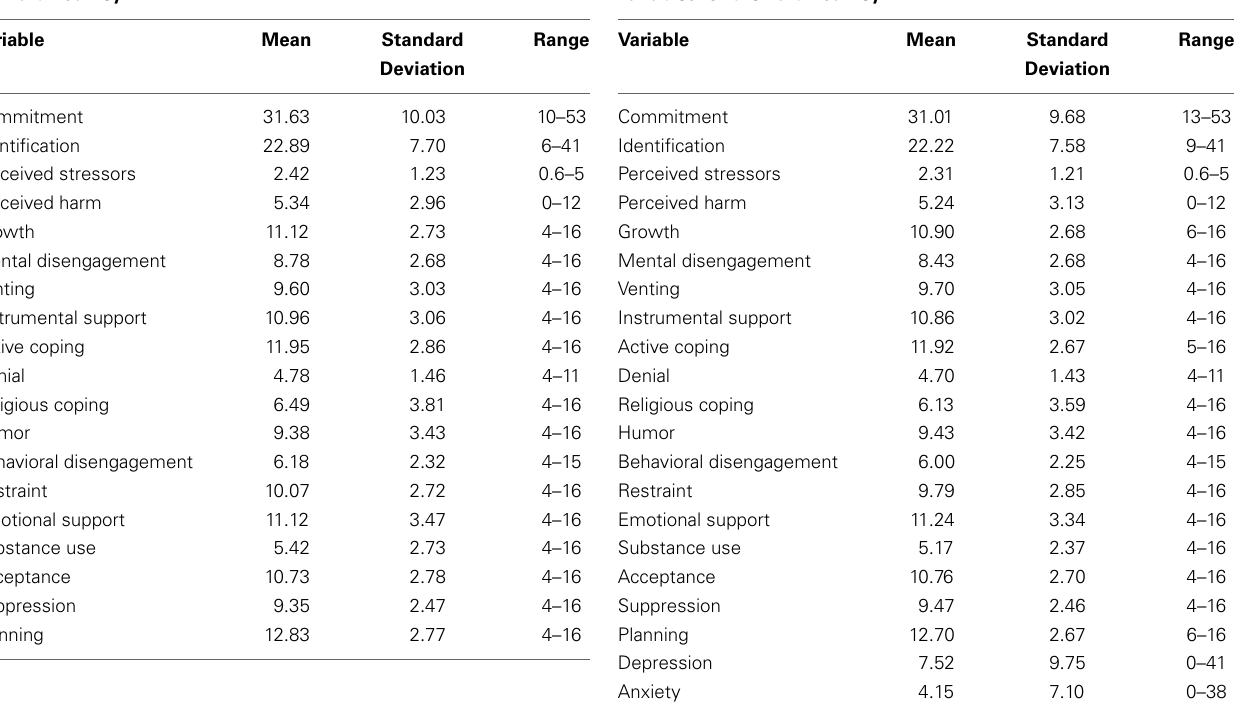
Table 3 | Means and standard deviations for commitment, identification, perceived stressors and harm, and COPE variables for the Part 1 survey.